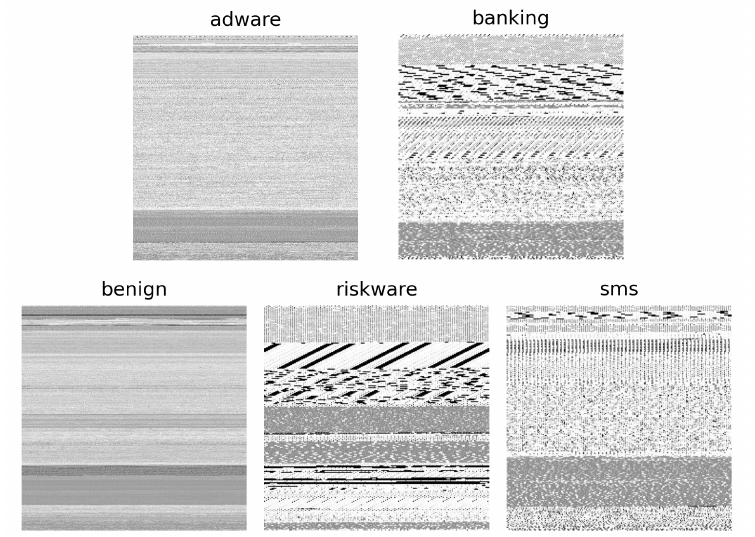
Figure 2. This is the result of converting APK files of five classes (benign and four malignant classes; adware, banking, riskware, and sms) constituting the CICMaldroid dataset into image files using Stream Order (SO). A single image was randomly selected for each class. If an image is chosen from the entire dataset, it is almost impossible to visually identify which class the selected image belongs